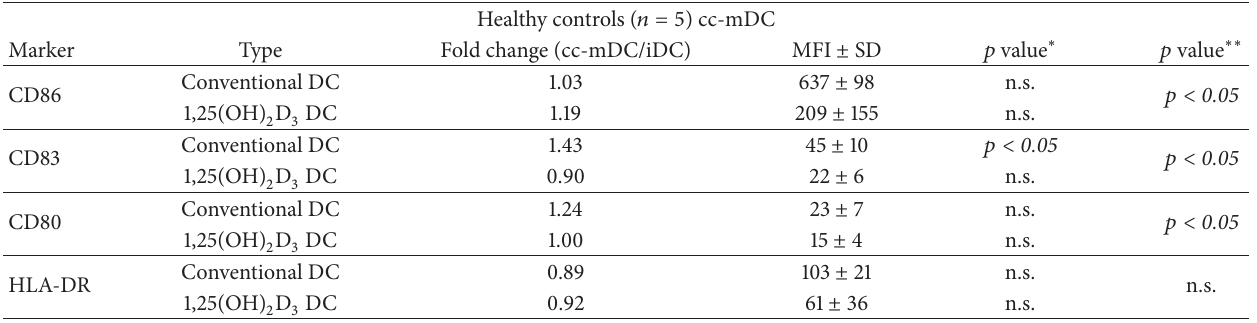
Table 3: Immunophenotypic analysis of in vitro differentiated mo-DC from healthy controls before and after cryopreservation. Healthy controls ( 𝑛 = 5 )